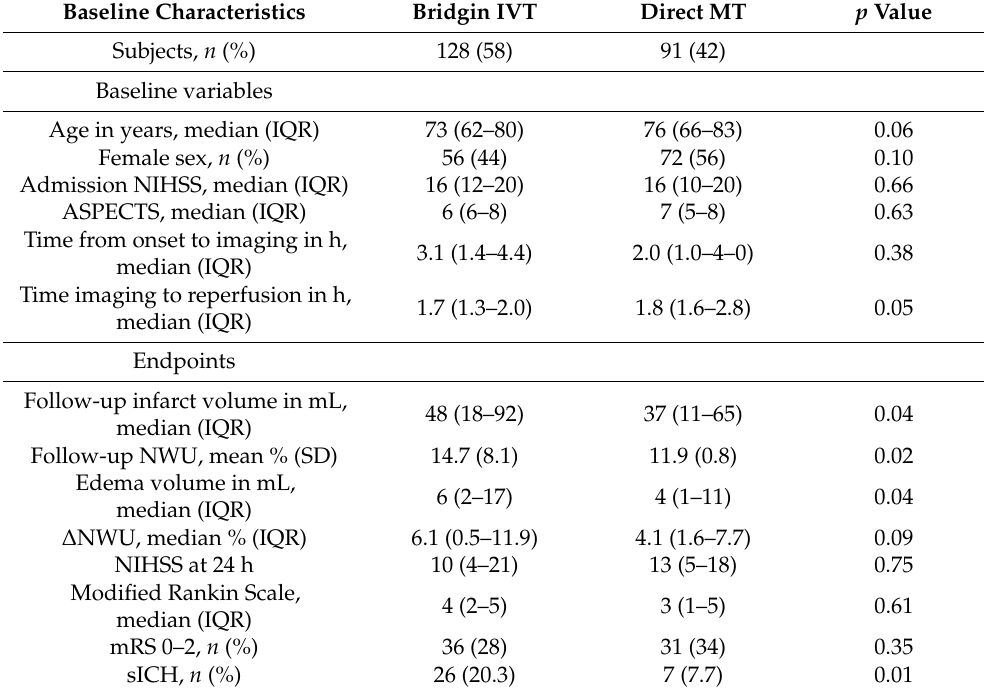
Table 1. Patient